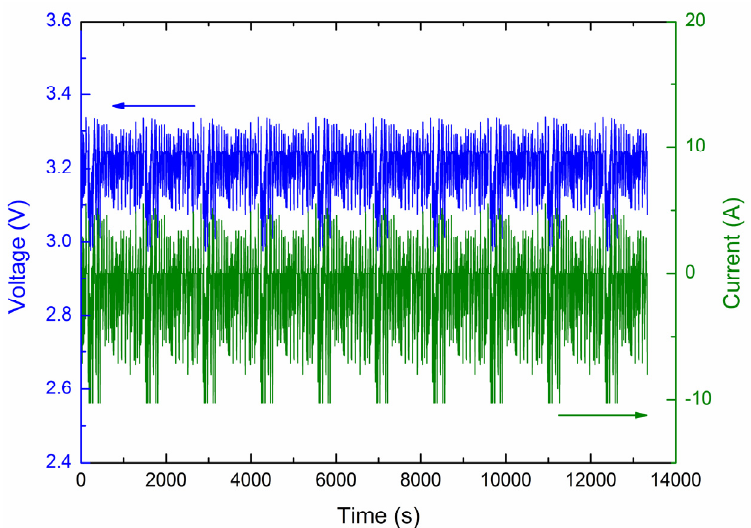
Figure 4. Synthesized current data and deduced voltage data from the equivalent circuit